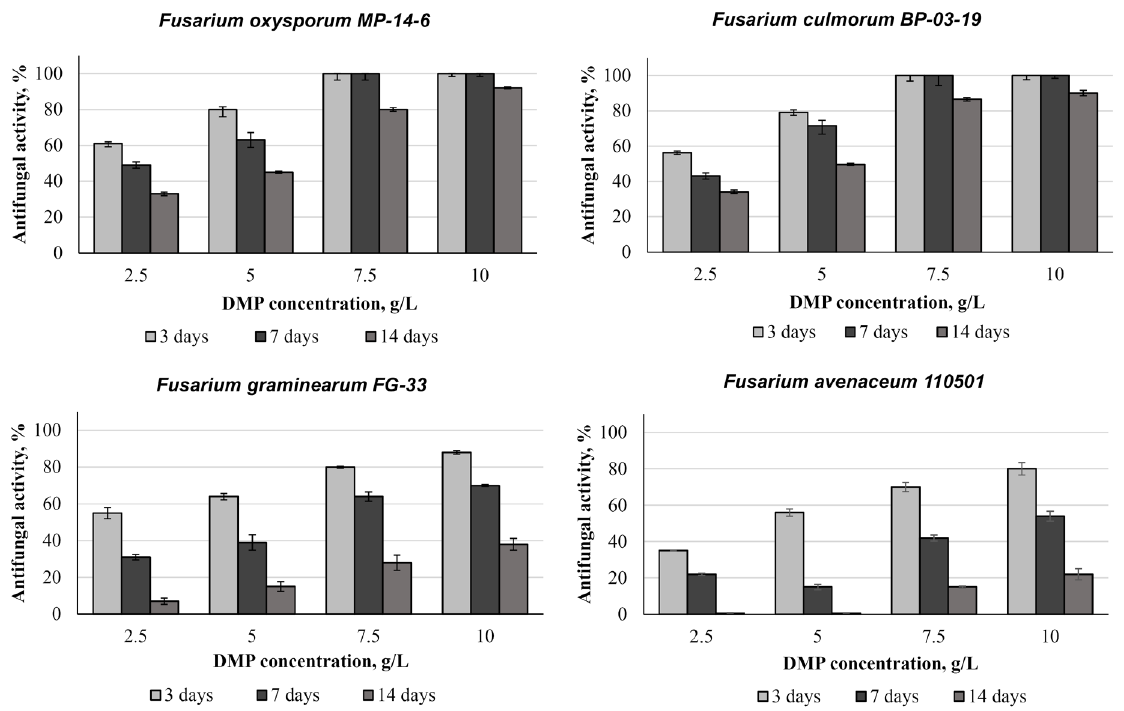
Figure 6. Antifungal activity of DMP towards the target pathogenic Fusarium fungi.